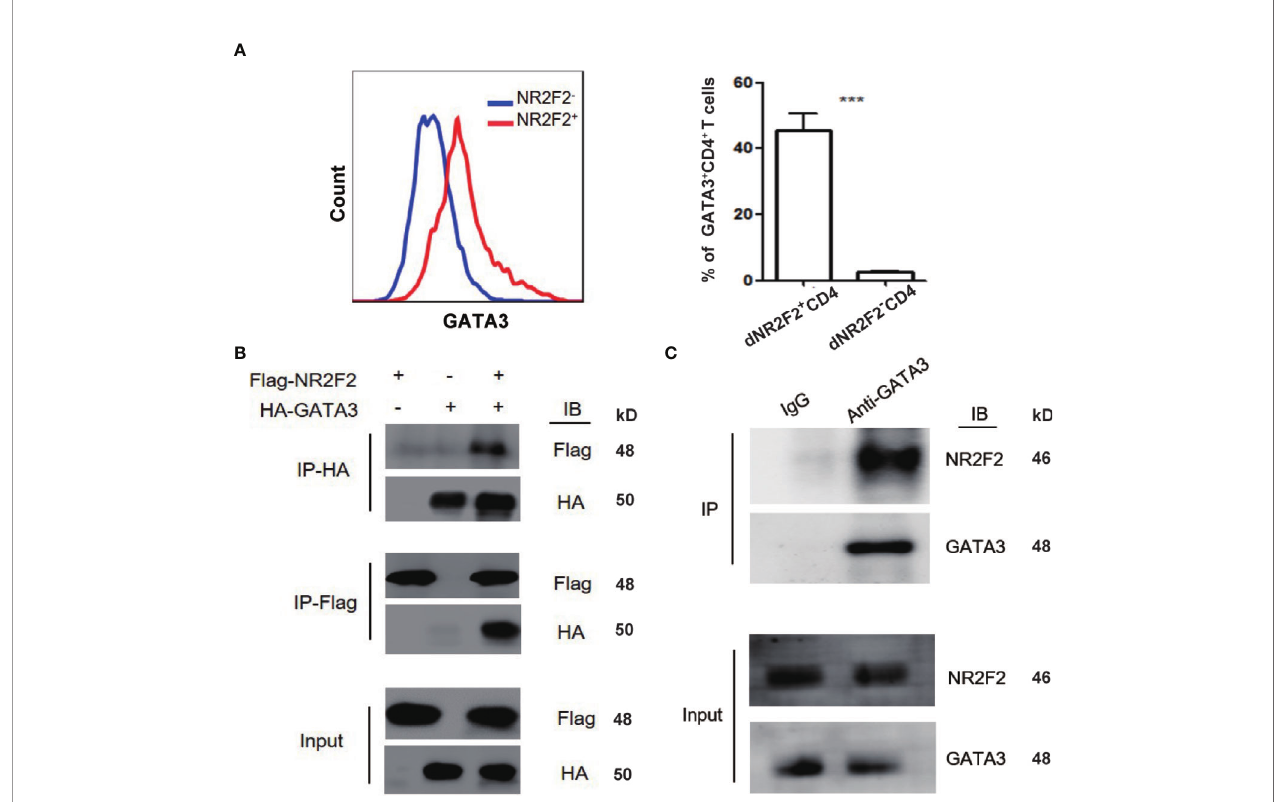
FIGURE 5 | NR2F2 is associated with GATA-3 in decidual CD4 + T cells. (A) Representative and quantitative images of GATA-3 proportions in NR2F2 + and NR2F2 - (B) Representative images of exogenous immune co-precipitation between NR2F2 and GATA-3 in 293T cells which infected with plasmid of NR2F2-Flag or GATA-3- HA for 24h. (C) Representative images of endogenous immune co-precipitation between NR2F2 and GATA-3 in dCD4 + T cells. ***P <